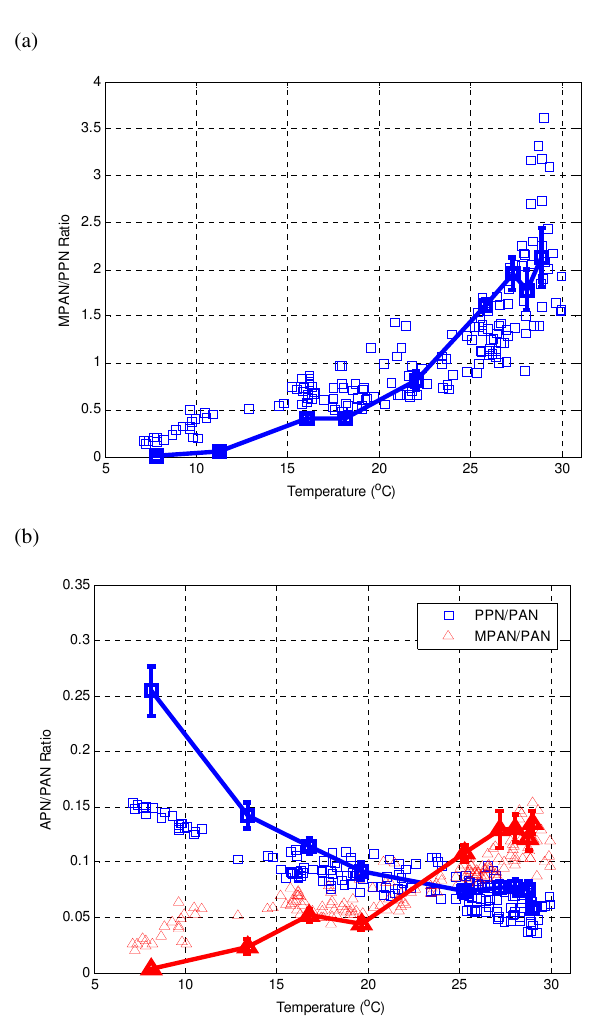
Fig. 5. Observed APN ratios vs. temperature: (a) MPAN/PPN (blue squares) and (b) MPAN/PAN (red triangles) and PPN/PAN (blue squares). Also shown are the steady-state predictions for each ratio, binned by temperature (connected symbols); the bars represent the 1 σ variance of the predicted mean.